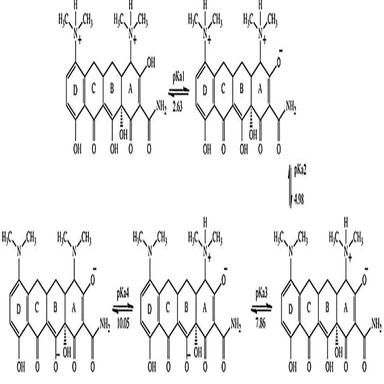
Differently protonated forms of minocycline.